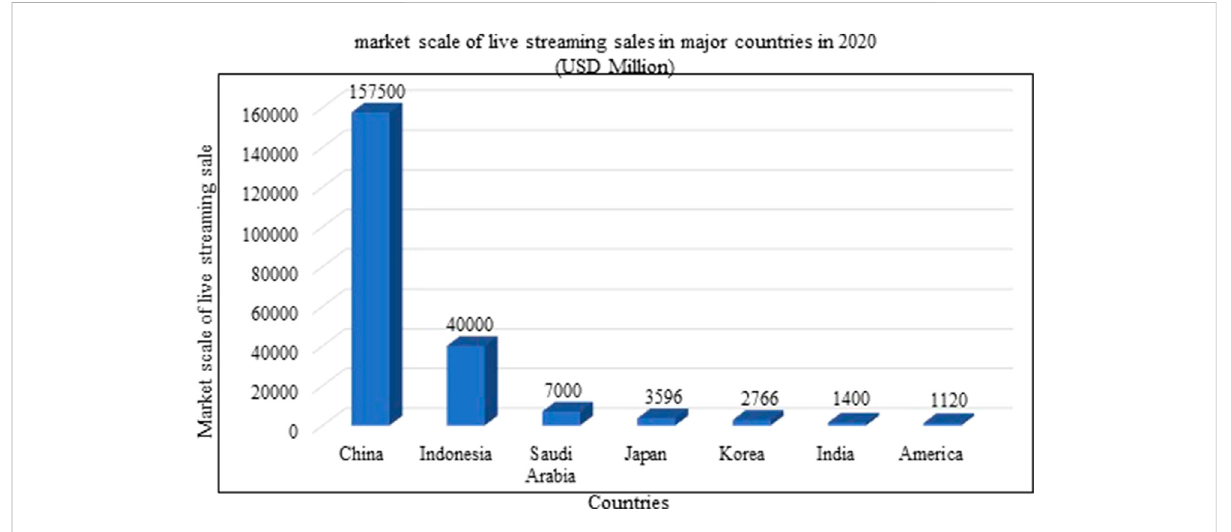
FIGURE 1 Scale of the livestreaming sales market in major countries in